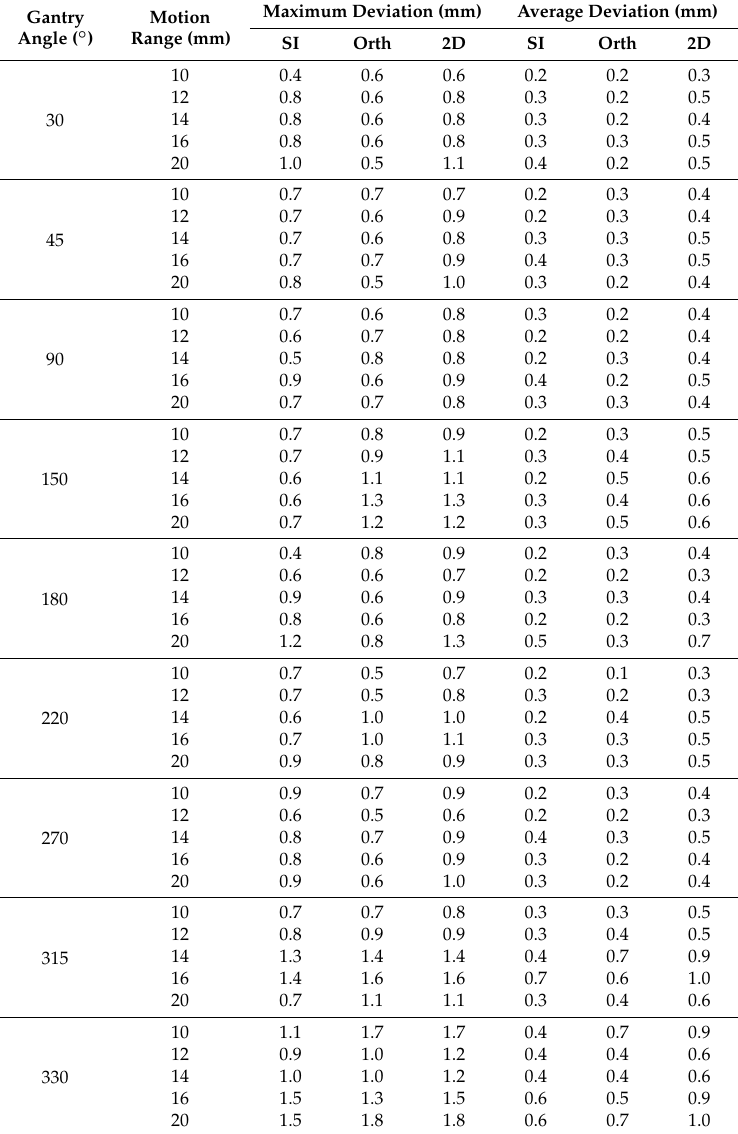
Table A1. Large tumor phantom-tracking evaluation result summary. Superior–inferior (SI), orthogonal (Orth), and 2D deviation results are